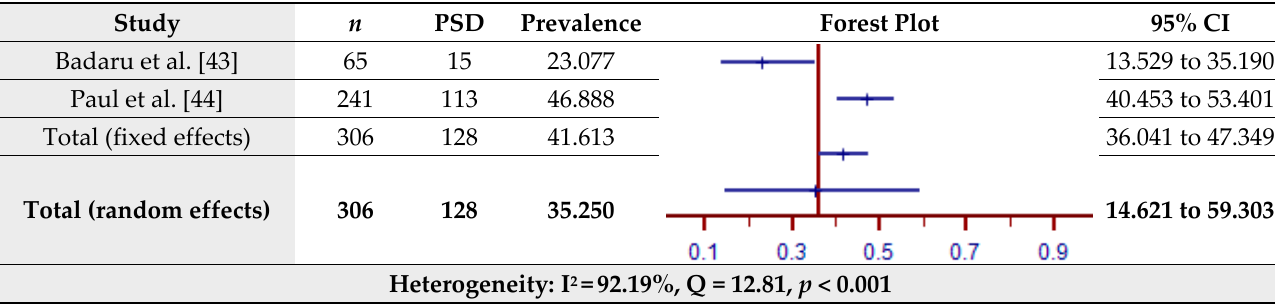
Figure 7. Prevalence estimates of Post-Stroke Depression (PSD) assessed by the Geriatric Depression Scale (GDS15/30).